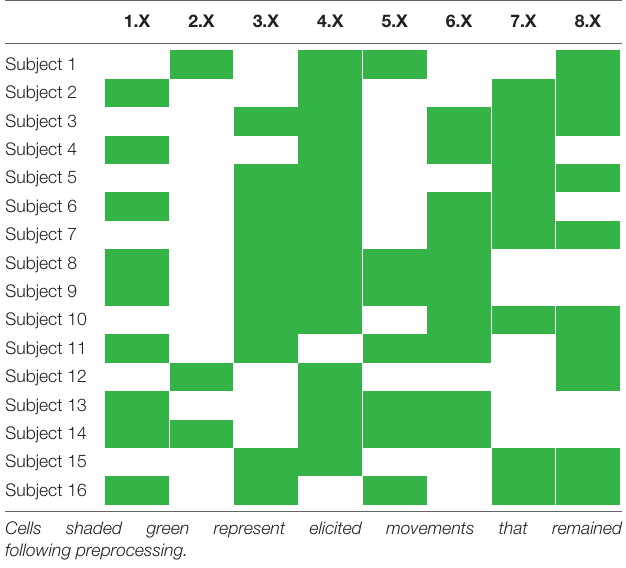
TABLE 2 | Overview of subject-wise elicited movements selected for regression model training and